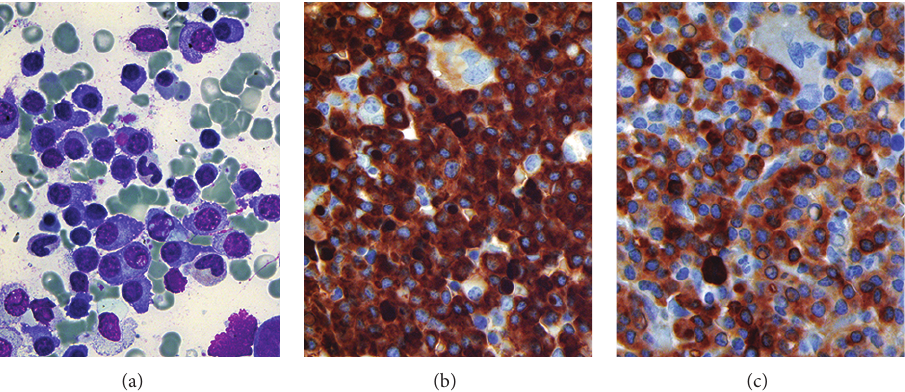
Figure 2: Case2. (a) Bone marrow aspirate reveals large numbers of mature-appearing plasma cells with lymphoplasmacytoid morphology, someofwhichcontainDutcherbodiesandcytoplasmicimmunoglobulininclusions.(b)Immunohistochemicalstudiesonthetrephinebiopsy demonstrate that almost all cells express IgM, some with Dutcher bodies. (c) A subset of cells also express IgD but at a weaker intensity than those expressing IgM. Wright-Giemsa, original magnification × 1000 (a); IgM, original magnification × 500 (b); IgD, original magnification × 500